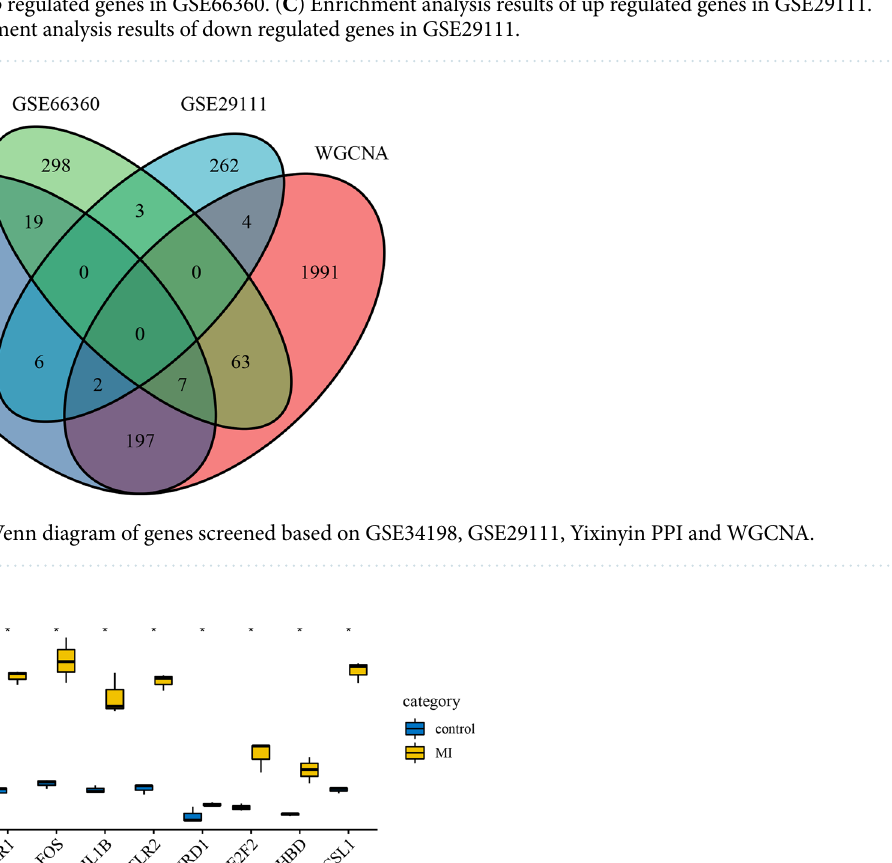
Figure 5. Enrichment analysis of DEGs based on metascape database (https:// metas cape. org/ gp/ index. html#/ main/ step1). ( A ) Enrichment analysis results of down regulated genes in GSE66360. ( B ) Enrichment analysis